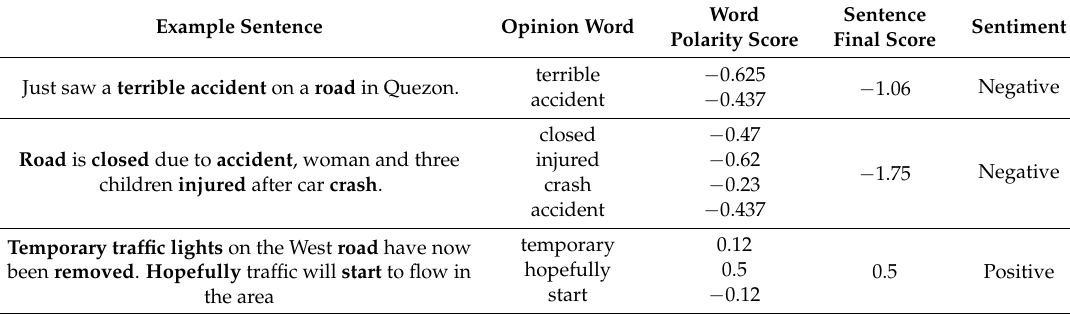
Table 1. Assigning polarity scores to words and